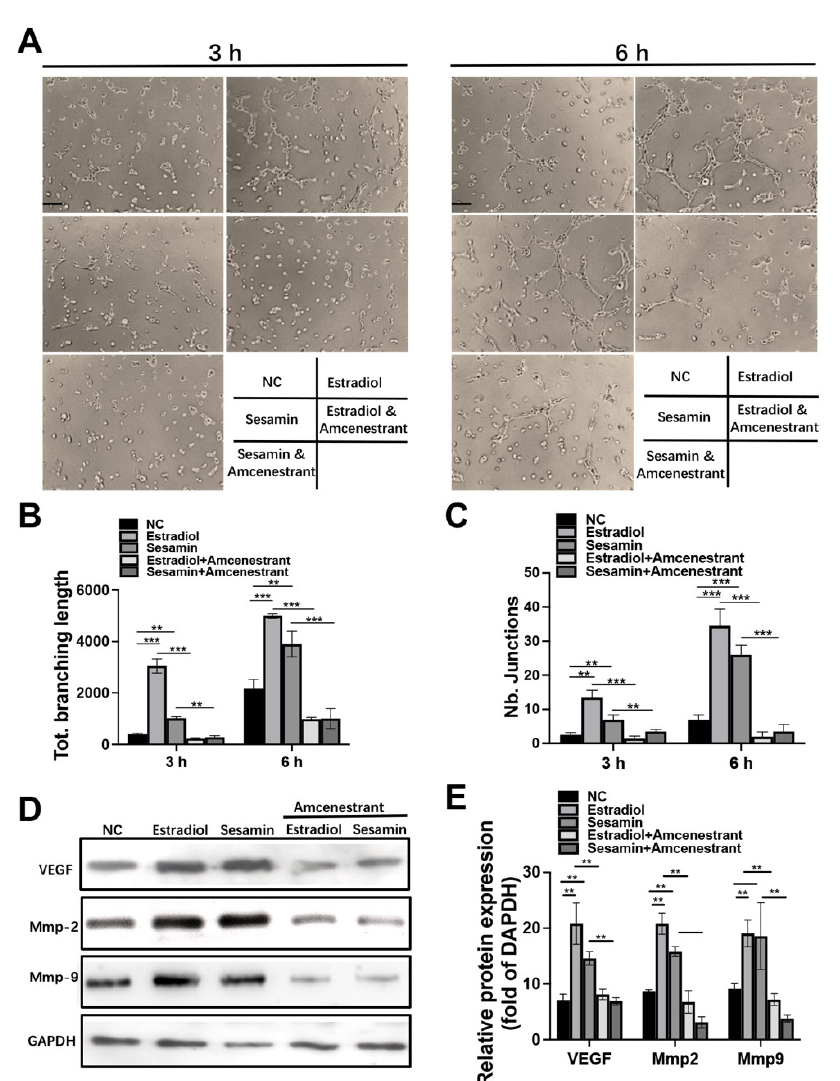
Figure 2. Sesamin promoted HUVECs angiogenesis in vitro: ( A ) Images of tube formation at 3 h and 6 h post-induction with the treatment of different combinations. ( B , C ) Semiquantitative analysis of total branching length of each group ( B ) and number of junctions ( C ) in each group. ( D , E ) Western blot ( D ) and semiquantitative analysis ( E ) of angiogenesis markers expression 6 h after angiogenesis induction ( n = 6; ** p < 0.01, *** p < 0.001).